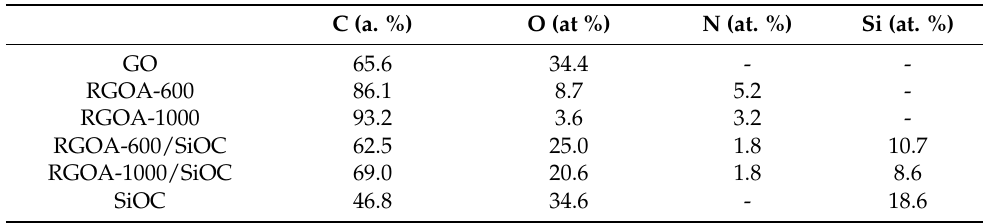
Table 2. Surface elemental composition from the survey X-ray photoelectronic spectra of GO, RGOA, SiOC, and RGOA-SiOC nanocomposites. C (a. %) O (at %) N (at. %) Si (at.